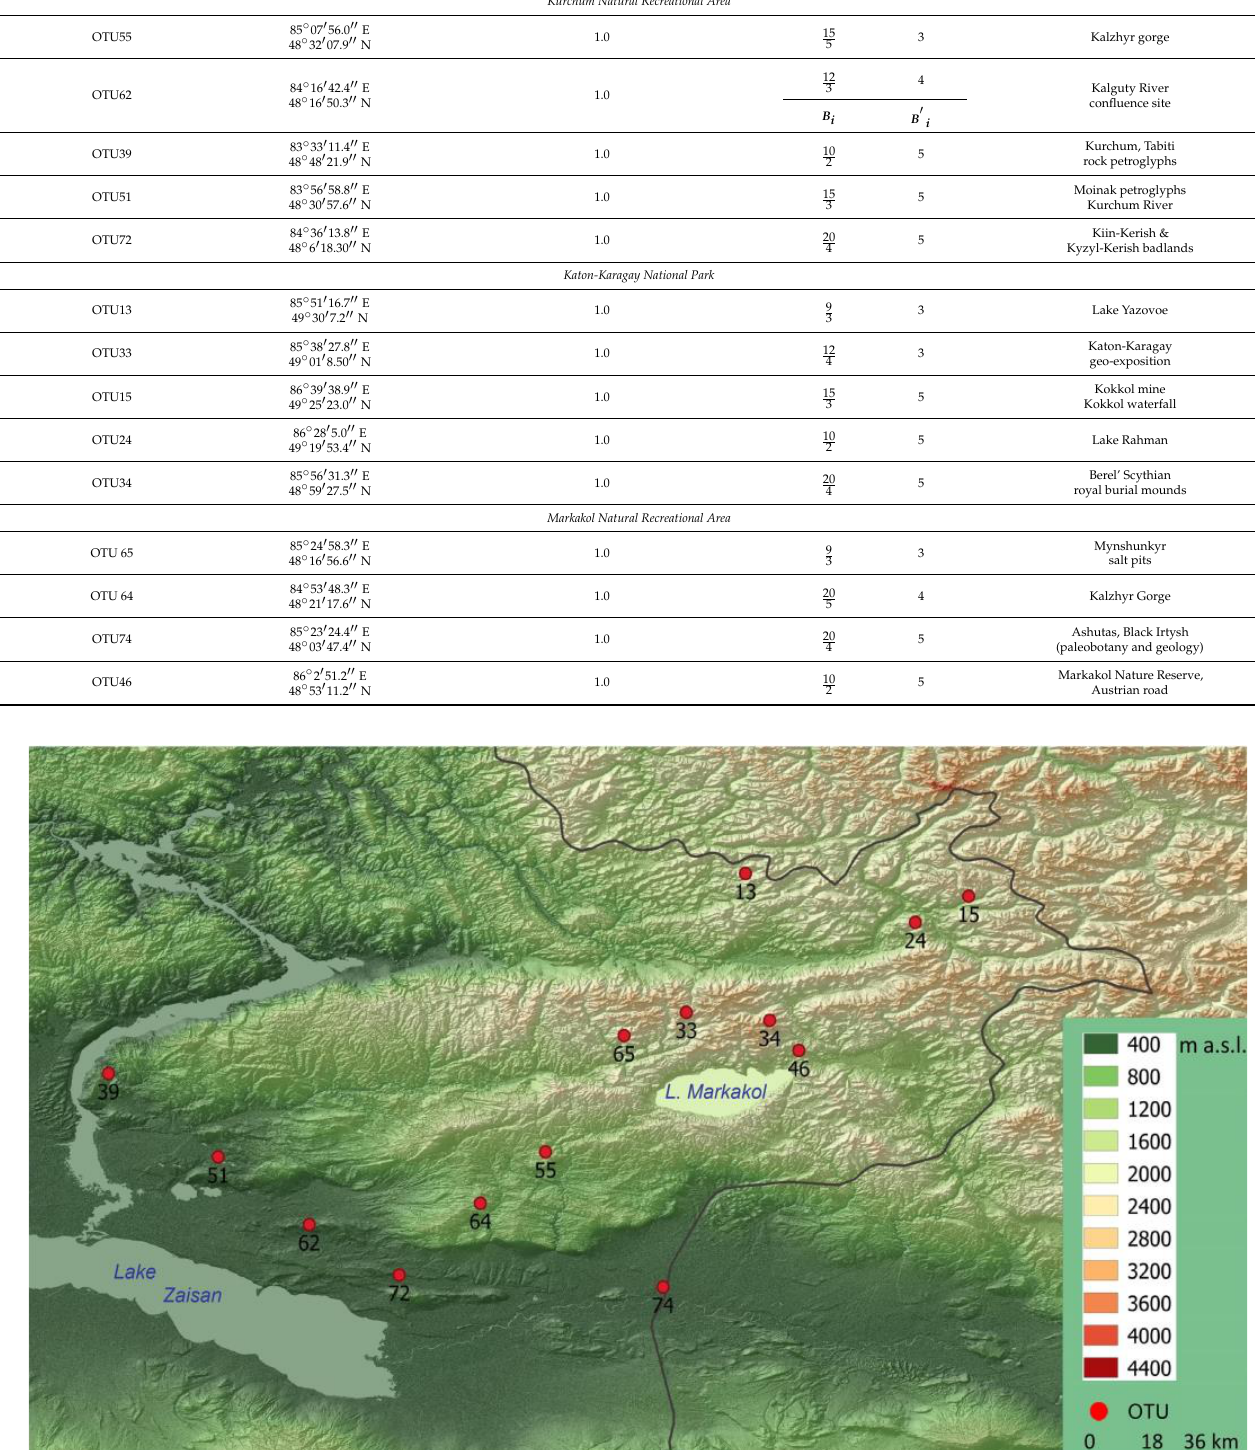
Table 2. The principal geotourism and geoheritage sites in the main East Kazakhstan recreational areas. MappedOperationalTerritorial Units(OTU)